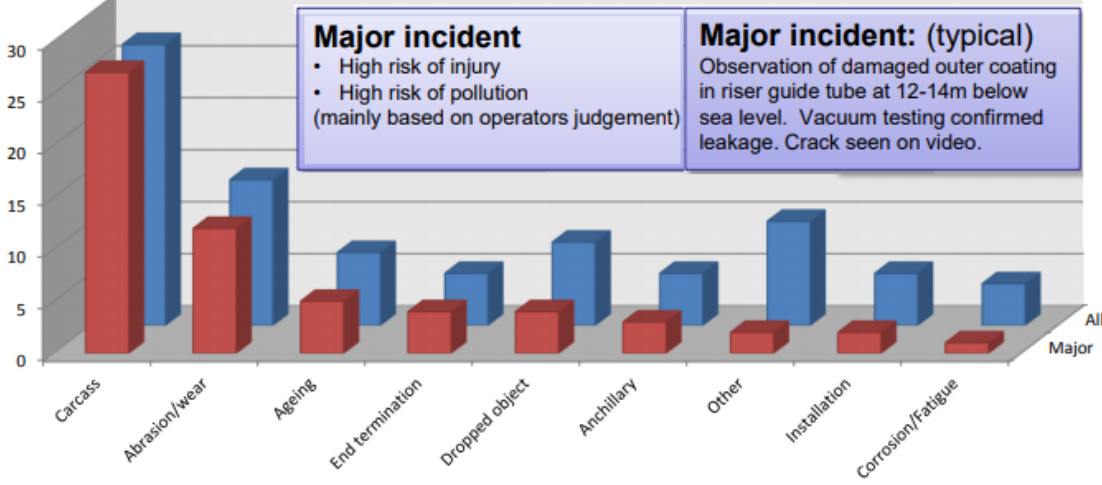
Figure 6. Flexible riser incidents as reported from CODAM to PSA Norway for 1995–2013 data (Source: PSA, in public domain).